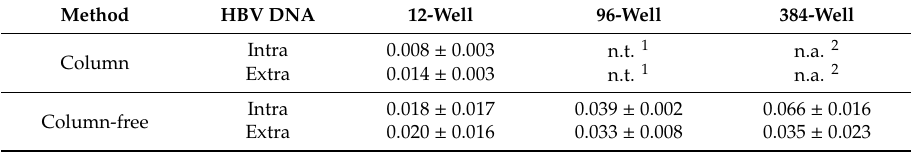
Table 1. Comparison of lamivudine 50% e ff ective concentration (EC 50 )